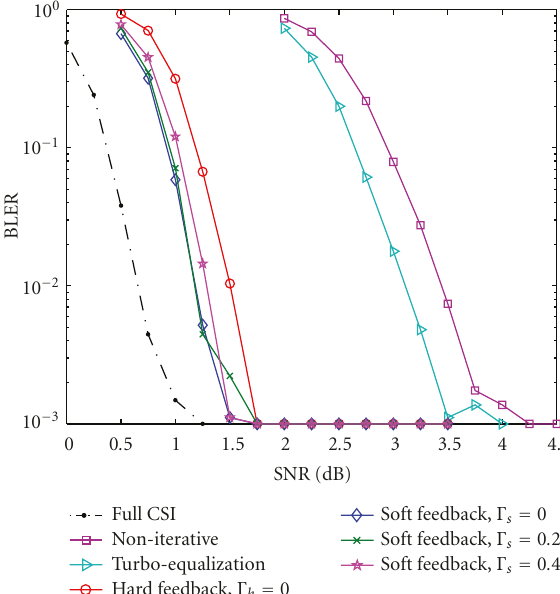
Figure 4: Simulation results, N t = 2, N r = 4, 16-QAM.